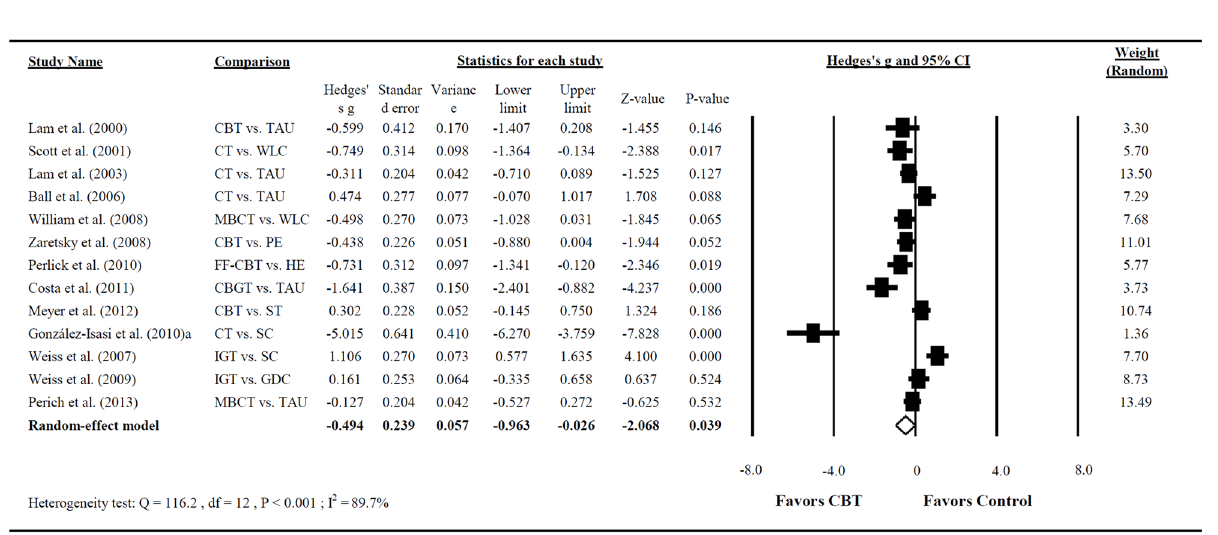
Fig 2. Forest plot of the meta-analysis for reducing depressivesymptoms in BD among patients treated with CBT compared with controls (n = 13 studies).